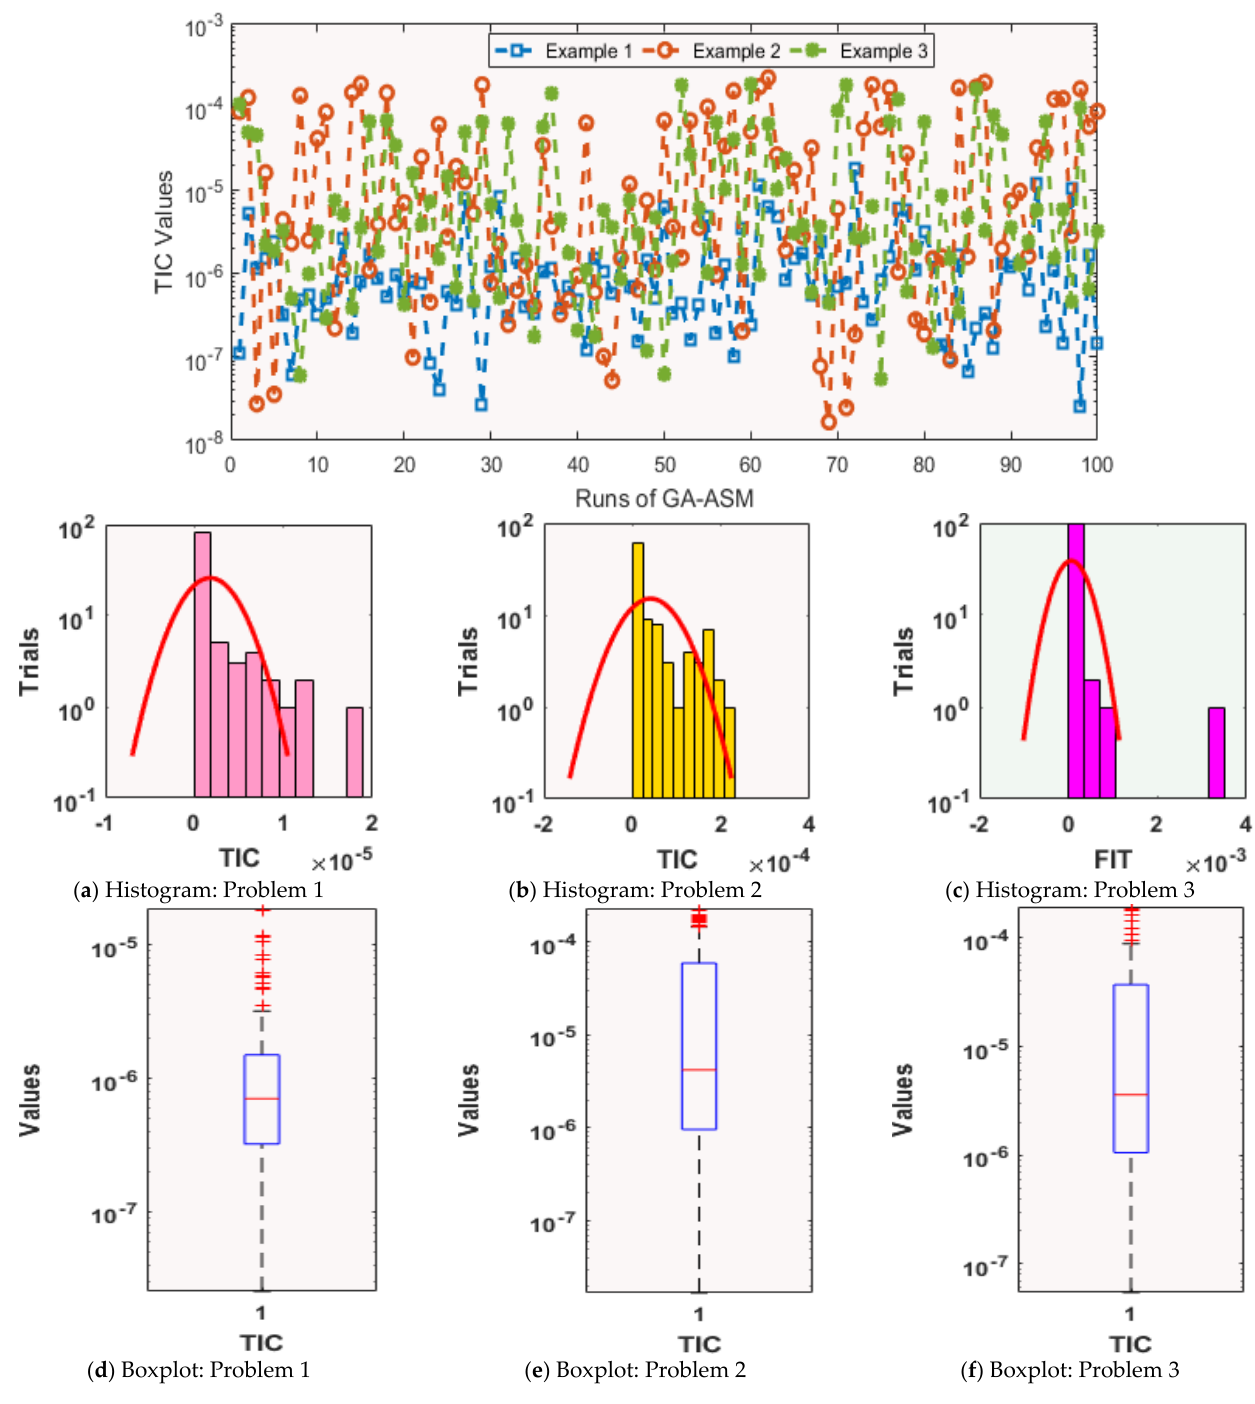
Figure 5. Convergence performances for the solution of Problems 1–3 based on the second kind of NLE-PDSM using ANN-GAASM in terms of TIC values; boxplots and histograms for 10 neurons. TIC on y -axis and independent executions on x -axis.